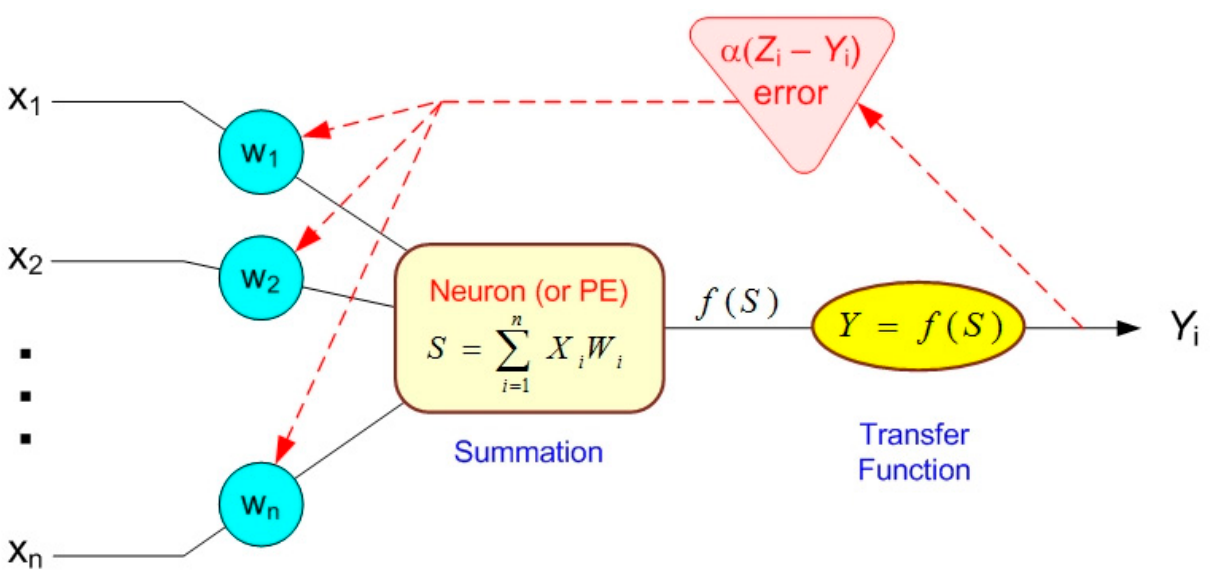
Figure 6. Backpropagation of neuron error [35].